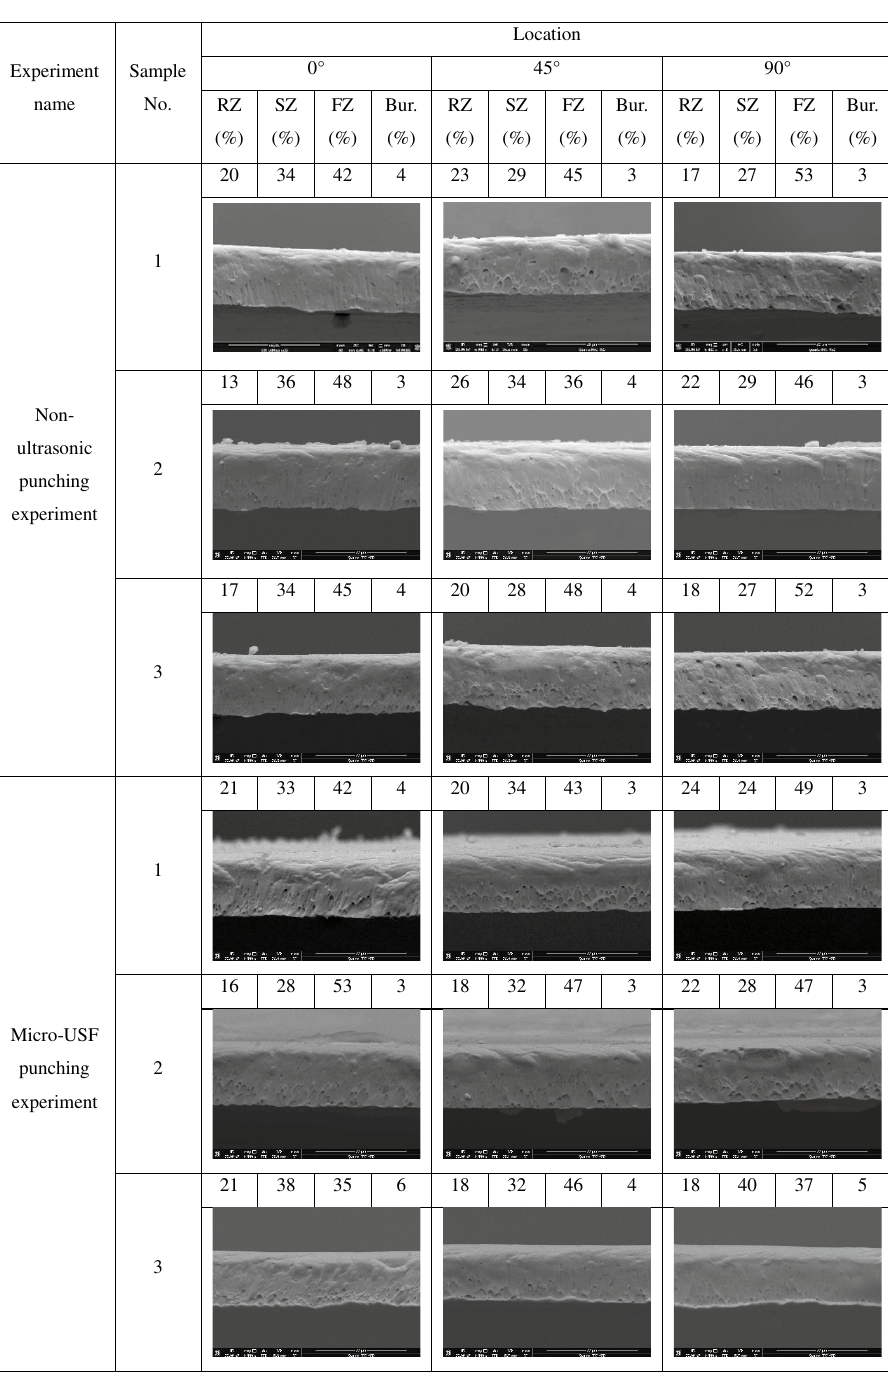
Table 7. The proportion of each zone at 0°, 45° and 90° of micro-holes